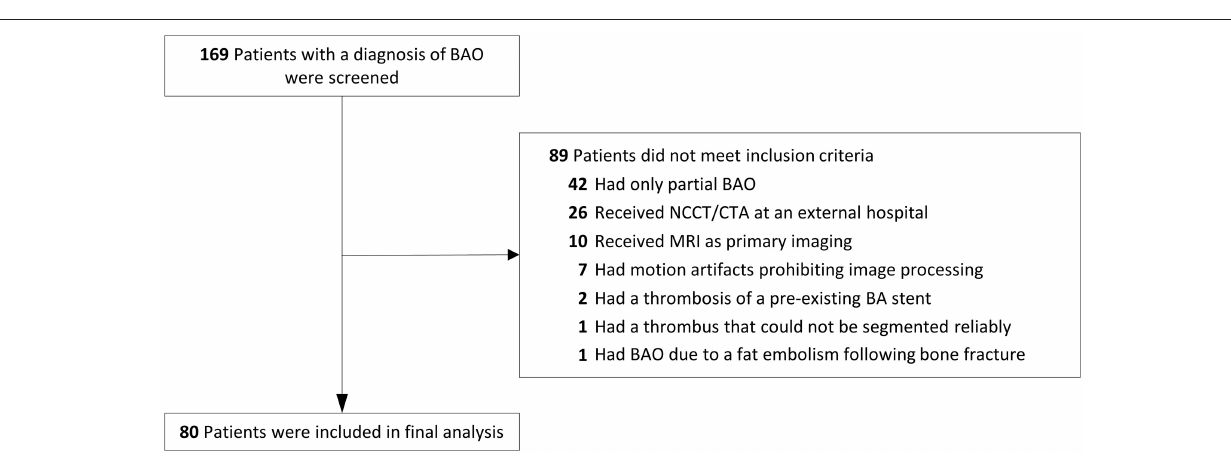
0.89 to 2.6; p = 0.115) and adjusted OR of 1.39 (0.70–2.7), p = 0.345) for successful recanalization. In a subgroup of 24 patients with available 90-day mRS, TP had a crude and adjusted OR for favorable outcome (mRS ≤ 2) of 1.05 (95% CI: 0.97–1.1, p = 0.205) and 1.1 (95% CI: 0.94–1.2, p =